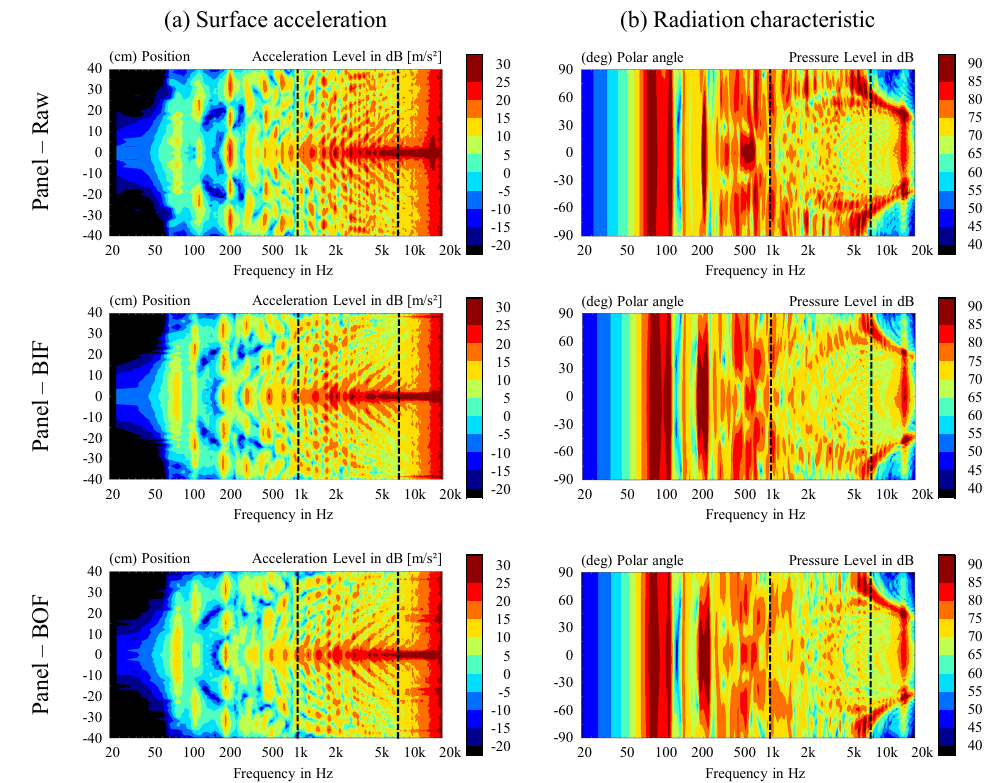
Figure 14. Comparison of the surface acceleration and directivity response of all three variants: Panel-Raw, Panel-BIF and